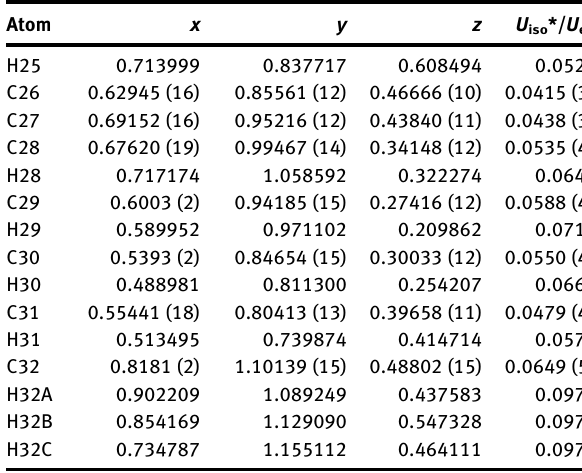
0.64 g) was added to a solution of 2-methoxy-benzalde- round bottom fl ask. The mixture was re fl uxed for 5 h, and then the precipitate was collected by fi ltration and washed with ethanol. The product was recrystallized from methanol to afford white crystal. Yield: 0.86 g (77.34%). m.p. : 212.1 –